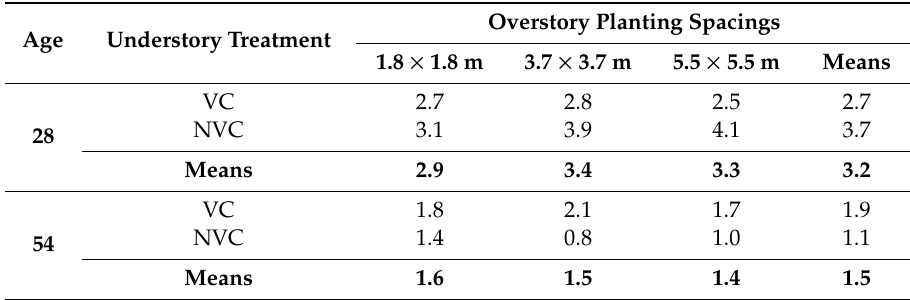
Table 4. C accumulation rates (Mg C ha − 1 yr − 1 ) at age 28 and 54 in the aboveground vegetation plus forest floor detritus for ponderosa pine plantations grown under three levels of planting densities and two understory vegetation control